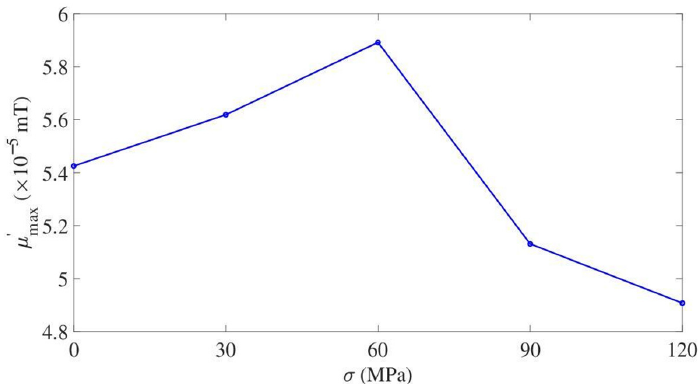
Figure 13. Maximum differential permeability relative to stress for specimen 2.